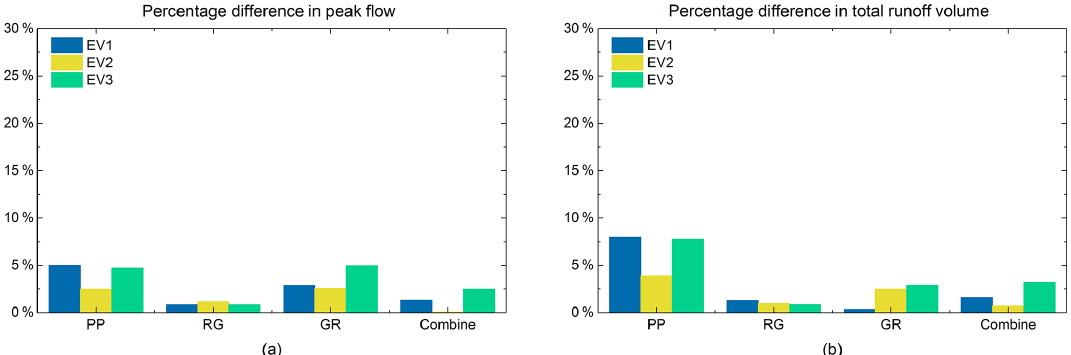
Figure 15. (a) Percentage difference in peak flow between the same types of NBS scenarios under the three uniform rainfall events. (b) Per- centage difference in total runoff volume between the same types of NBS scenarios under the three uniform rainfall events.